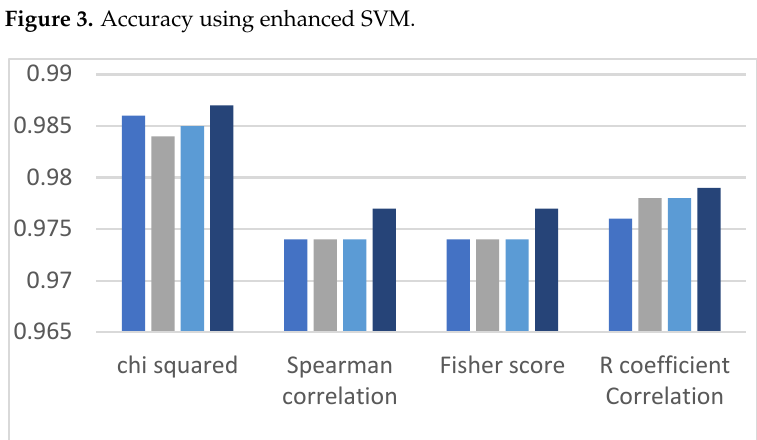
Figure 4. Accuracy using enhanced Decision Tree.